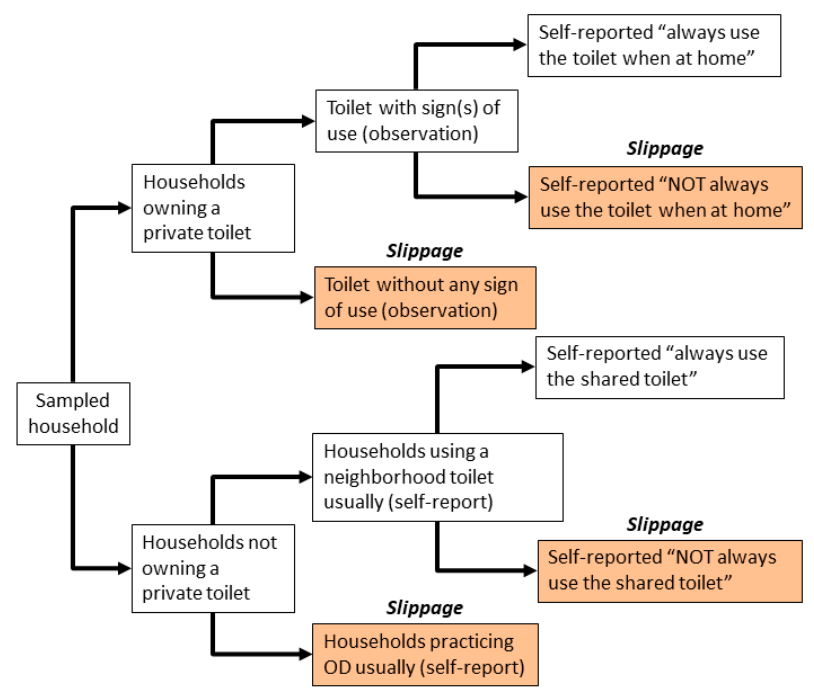
Figure 2. Flow diagram for identifying households that have slipped back based on observation and self-reported data of their latrine usage in this study.